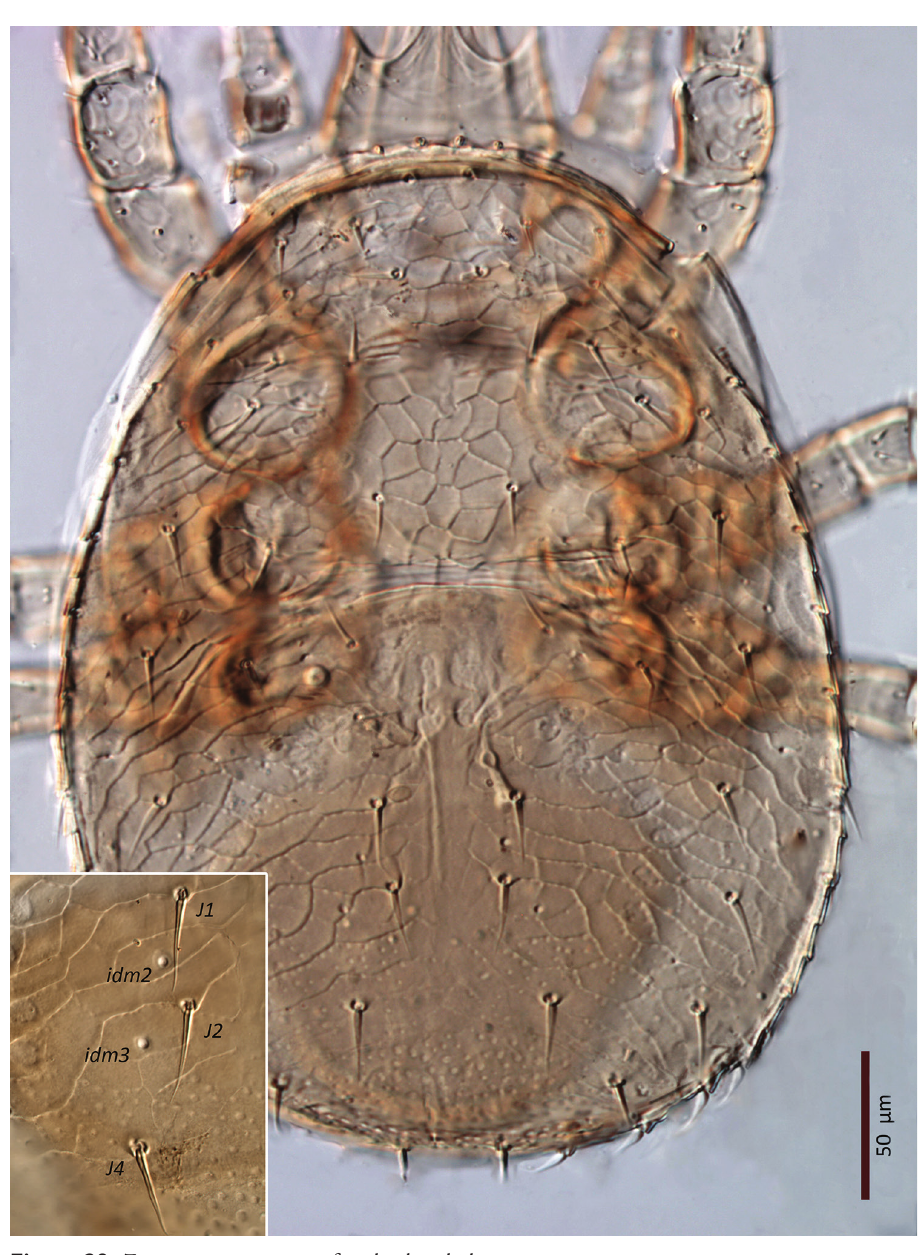
Figure 28. Zygoseius papaver sp. n., female, dorsal idiosoma.